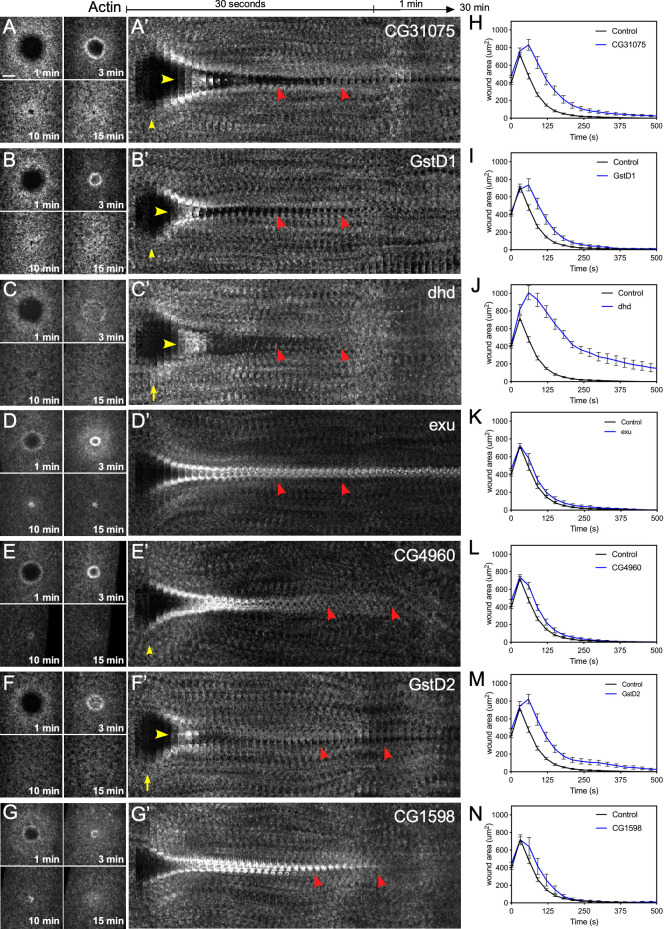
Knockdown of down-regulated genes results in wound over-expansion and abnormal actin dynamics.(A-G) Confocal XY projections of actin dynamics at 1, 3, 10, and 15 mpw from Drosophila NC4-6 embryos coexpressing sGMCA and a UAS-RNAi transgene during cell wound repair for CG31075RNAi/+; sGMCA, 7063/+ (A), GstD1RNAi/+; sGMCA, 7063/+ (B), dhdRNAi/+; sGMCA, 7063/+ (C), ExuRNAi/+; sGMCA, 7063/+ (D), CG4960RNAi/+; sGMCA, 7063/+ (E), GstD2RNAi/+; sGMCA, 7063/+ (F), CG1598RNAi/+; sGMCA, 7063/+ (G). (A’-G’) XY kymographs across the wound areas depicted in (A-G), respectively. Note wound overexpansion (yellow arrows), wound underexpansion (green arrows), internal actin accumulation (yellow arrowhead), and remodeling defect/open wound (red arrowhead). (H-N) Quantification of wound area over time for (A-G’), respectively. Error bars represent ± SEM; n ≥ 10. See S3 Table for numerical data. Scale bars: 20 μm.